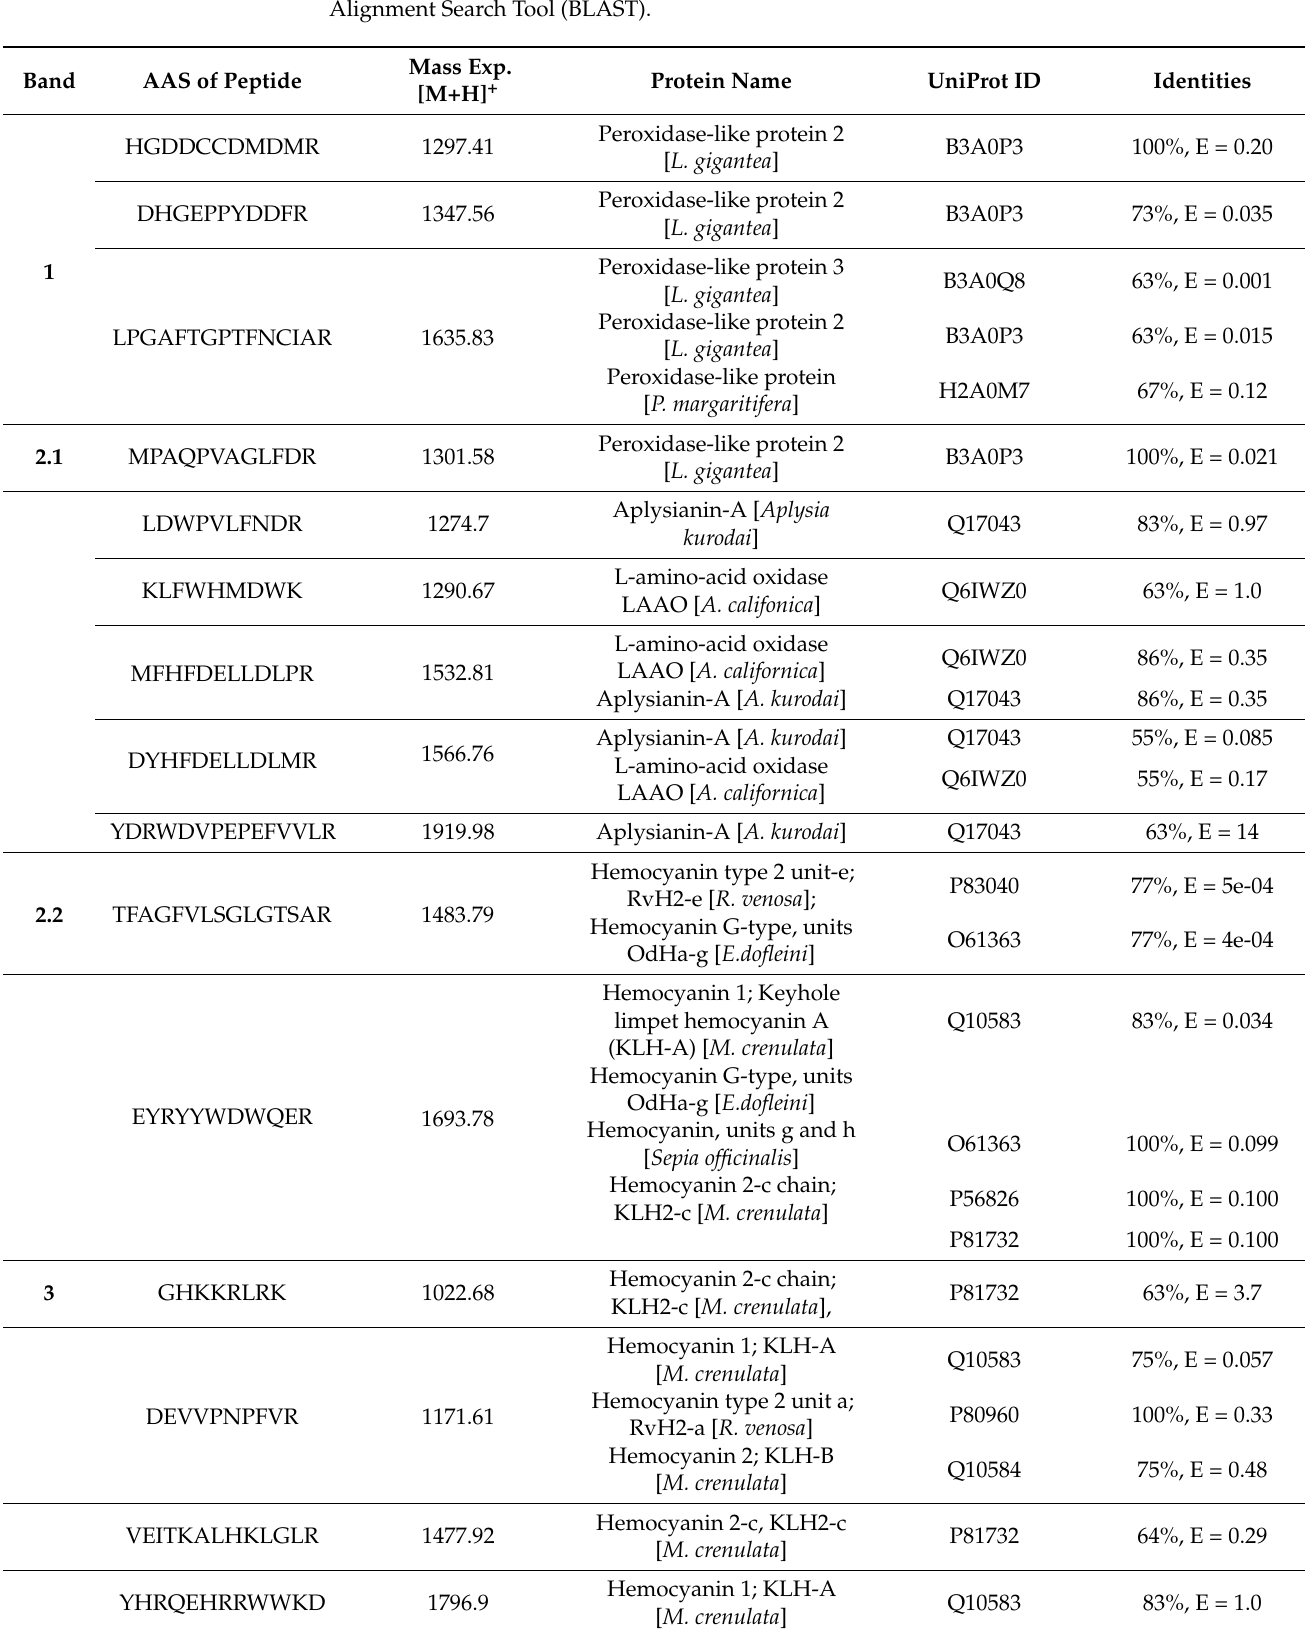
Table 1. Amino acid sequences (AASs) of peptides, determined after analysis of their MS/MS spectra. Proteins were identified after comparing AASs with database of protein sequences by the Basic Local Alignment Search Tool